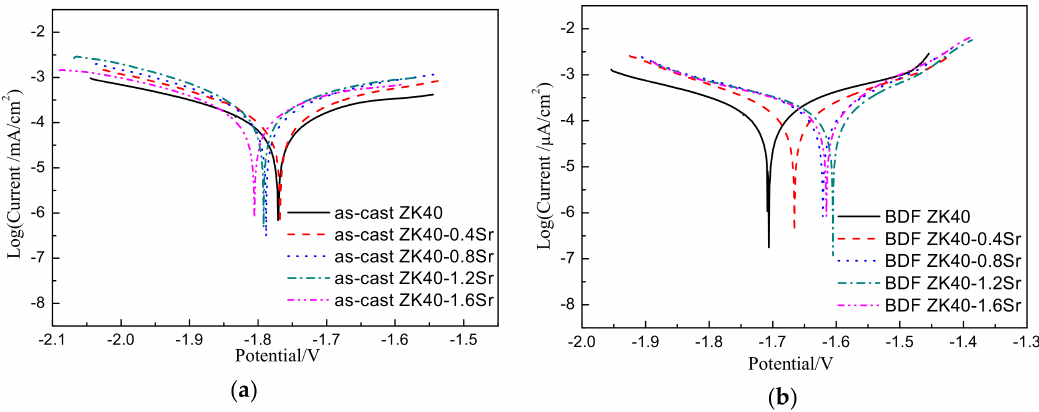
Figure 4. Potentiodynamic polarization curves of the as-cast ( a ) and BDF ZK40-xSr alloys ( b ) in modified simulated body fluid (m-SBF) at 37 ◦